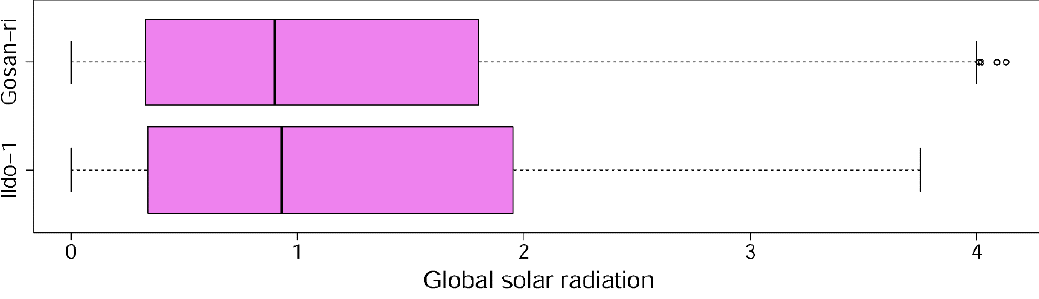
Figure 5. Boxplots by region (MJ/m 2 ).